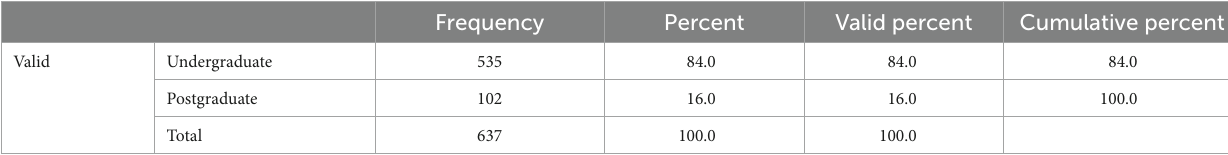
TABLE 1 General information of the